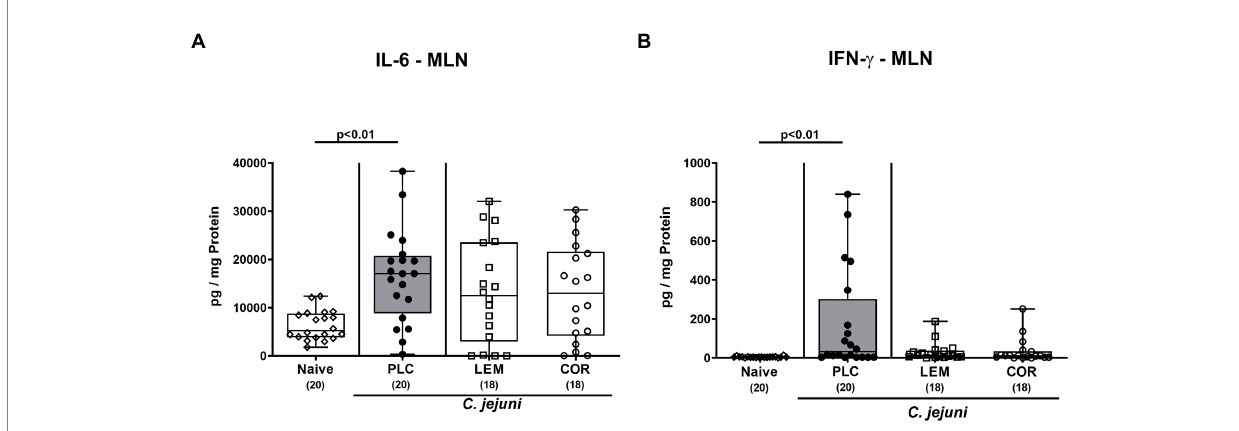
FIGURE 5 Intestinal pro-inflammatory cytokine secretion in mesenteric lymph nodes following prophylactic oral application of lemon or coriander essential oil to C. jejuni infected mice. SAB IL-10 − / − mice were subjected to prophylactic lemon (LEM; white squares) or coriander (COR; white circles) essential oil via the drinking water ( ad libitum ) starting seven days prior infection. Placebo (PLC; black circles) control animals received tap water only. On days 0 and 1, mice were then perorally infected with C. jejuni strain 81–176 by gavage. On day 6 post-infection, (A) IL-6 and (B) IFN- γ concentrations were measured in ex vivo biopsies derived from mesenteric lymph nodes (MLN). Naive mice were included as non-infected, untreated controls (white diamonds). Box plots (indicating the 25th and 75th percentiles), whiskers (indicating the minimum and maximum values), medians (black bar inside box) and numbers of analyzed mice (in parentheses) are shown. Significance levels ( p values) were calculated by the Kruskal-Wallis test with Dunn’s post-correction using pooled data from four independent